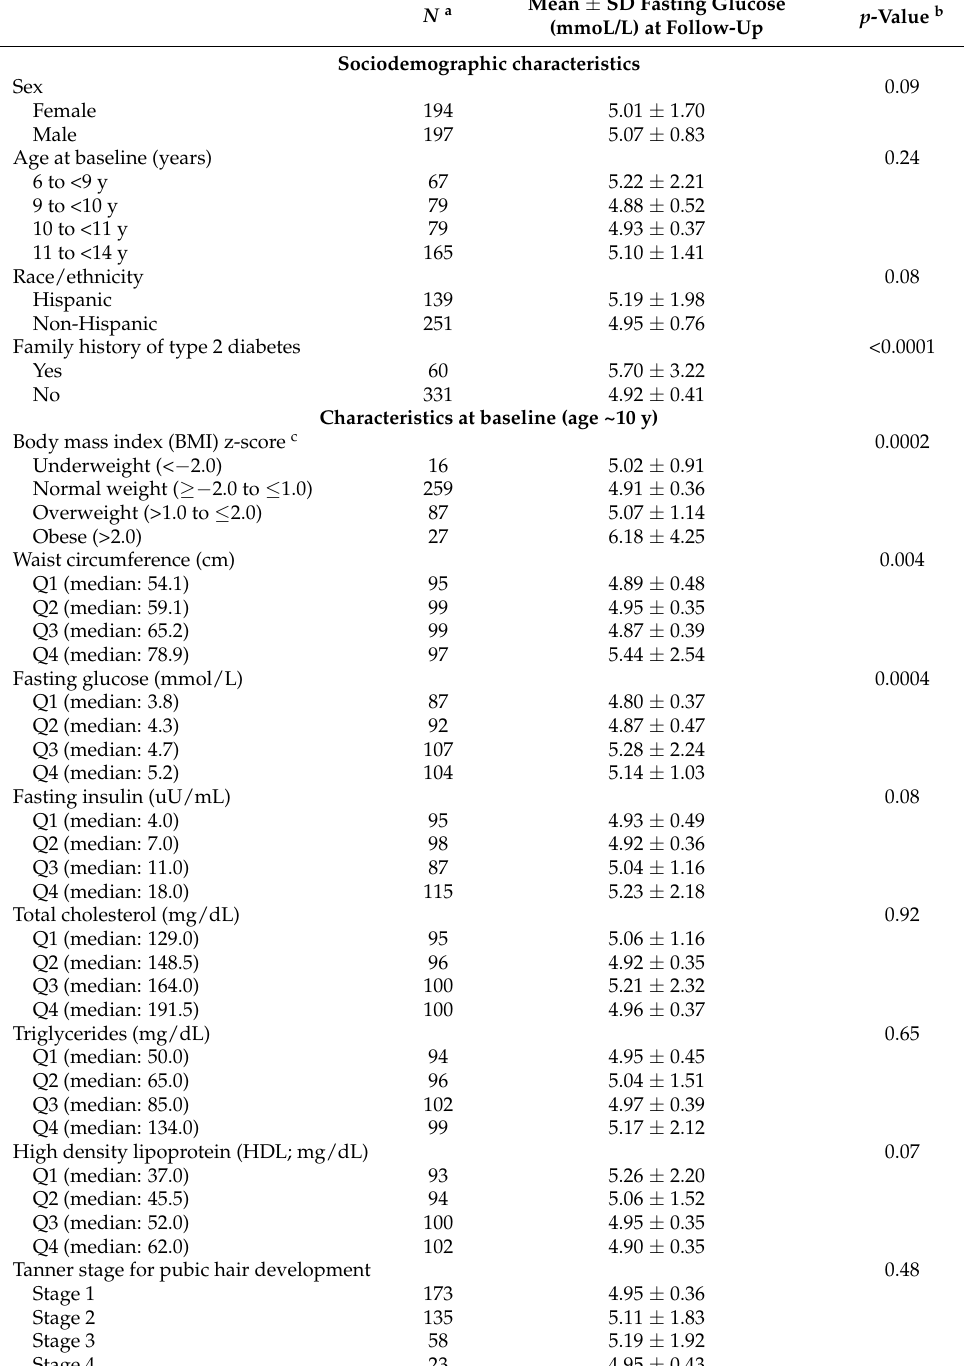
Table 1. Bivariate associations of background characteristics at baseline (age ~10 y) with fasting glucose at follow-up (age ~16 y) among 391 EPOCH